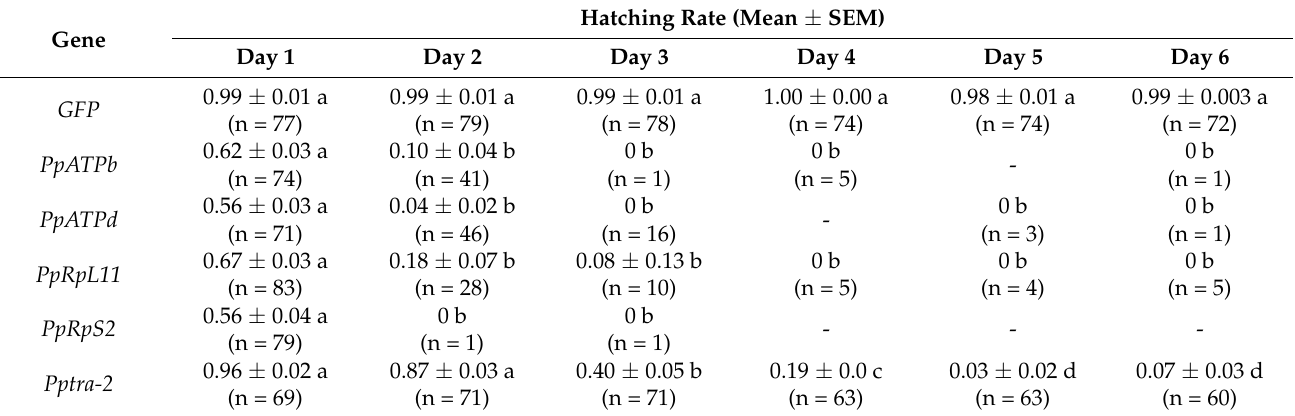
Table 3. Daily hatching rate of eggs produced by Phytoseiulus persimilis when five genes were interfered. Hatching Rate (Mean ± SEM) Gene